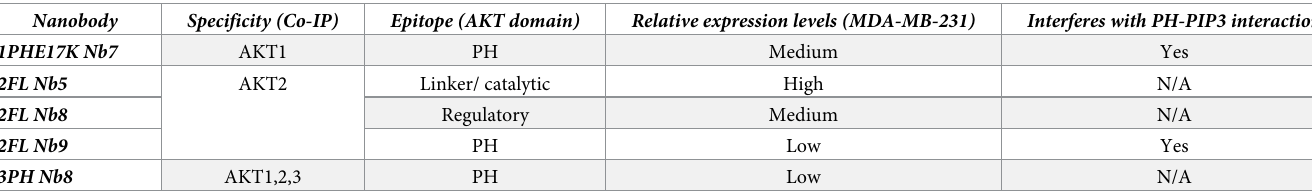
Table 1. Summary of characteristics for relevant AKT